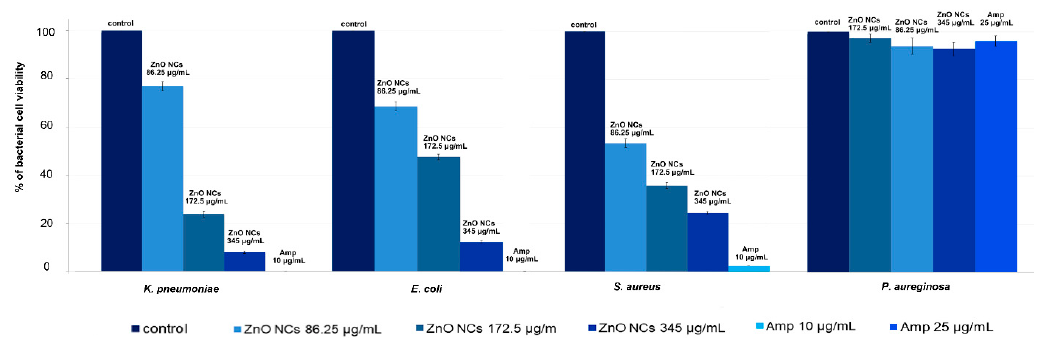
Figure 8. Quantification of bacterial cell viability (%) at different concentrations of ZnO NCs and ampicillin.